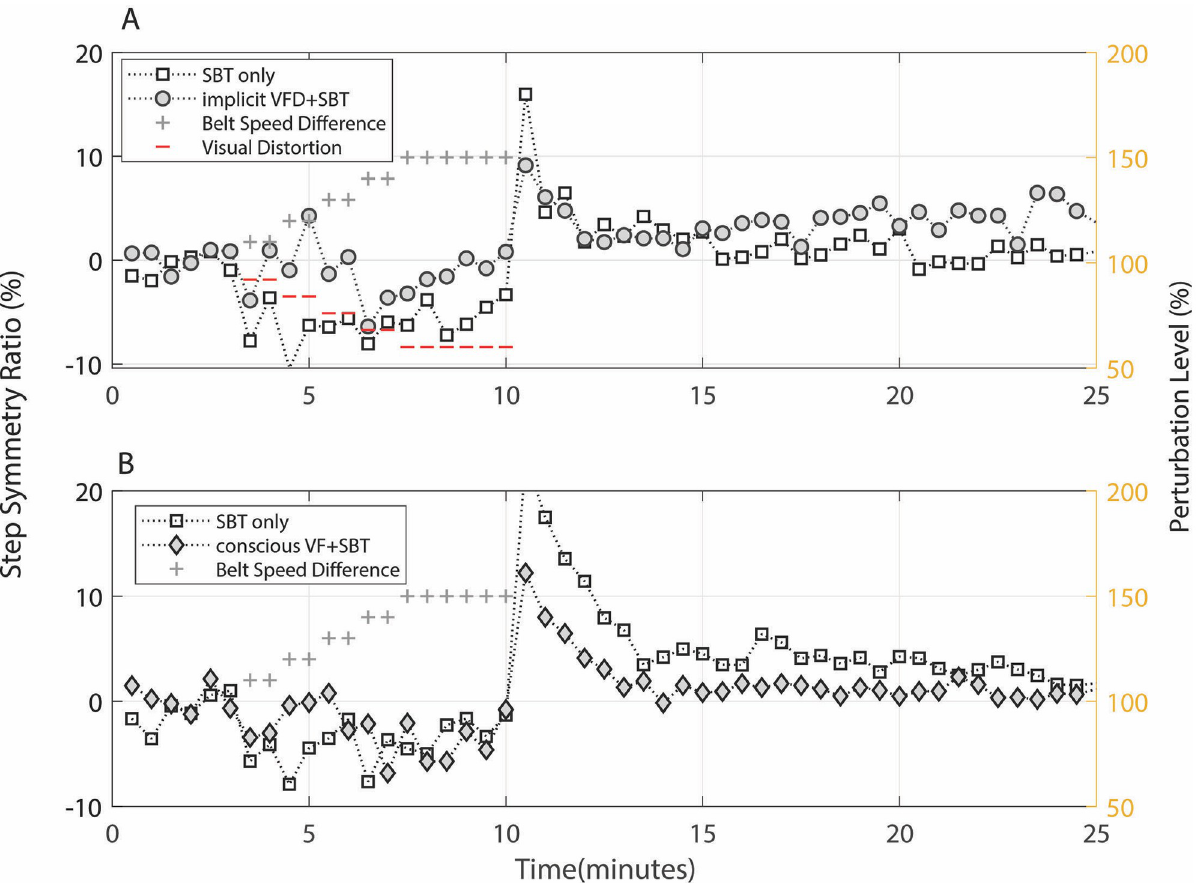
Fig 2. Changes in step length symmetry. A : Example of changes in step length symmetry resulted from the SBT-only trial and the implicit VFD+SBT trial obtained from a subject. B : Example of changes in step length symmetry resulted from the SBT-only and the conscious VF+SBT trials obtained from another subject. In all trials, visual distortion and split-bet perturbations were only used during the first 13 minutes (adaptation period). The intermittent horizontal lines indicate distortion or perturbation increments applied during those time periods. The horizontal axis shows time; the vertical axis shows the step length symmetry ratio between the actual left and right step lengths. The markers represent the mean step length symmetry value averaged over 30-second intervals at a given time.